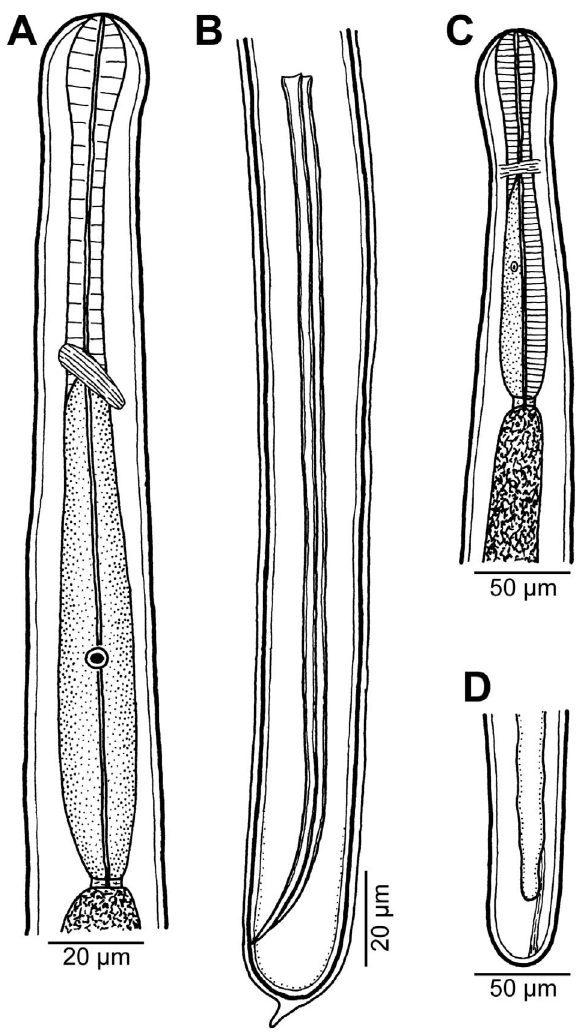
Figure 3. Philometra sp. from Epinephelus maculatus . (A, B) Anterior and posterior ends of male fourth-stage larva, respectively, lateral views; (C, D) anterior and posterior ends of mature female, respectively, lateral